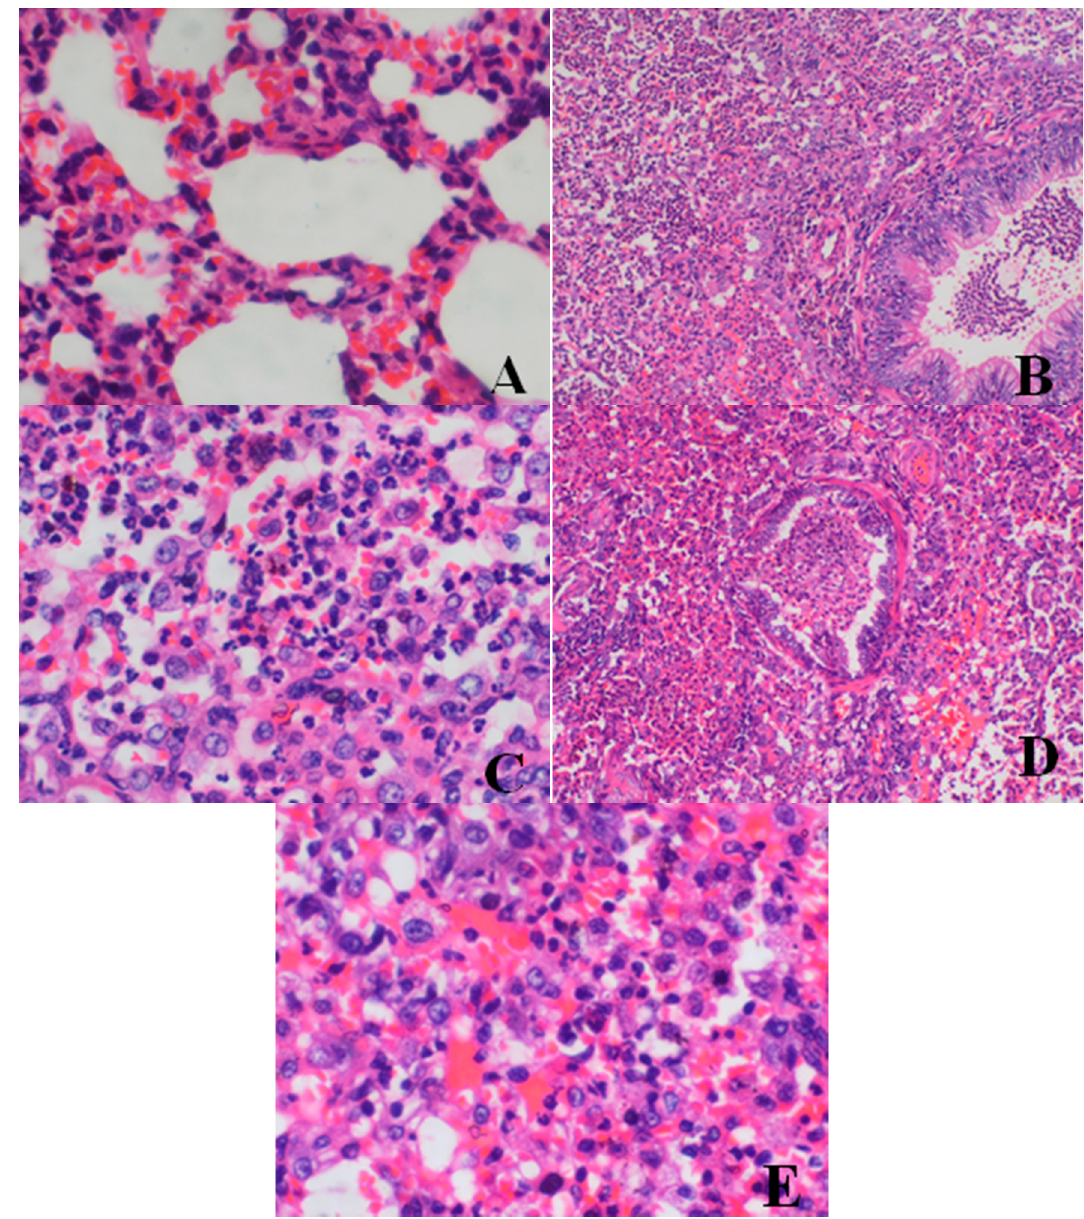
Figure 3. Hematoxylin and eosin-stained histologic sections of dogs’ lungs ( A – E ). ( A ) Histopathological photomicrograph of lung from ♀ 26 belonging to the control group at d28 (original magnification × 400): normal structure; ( B ) lung from ♂ 5 belonging to the 80-mg/kg dose group at d28 (original magnification × 100); ( C ) lung from ♂ 5 belonging to the 80-mg/kg dose group at d28 (original magnification × 400); ( D ) lung from ♂ 23 belonging to the 40-mg/kg dose group at d28 (original magnification × 100); ( E ) lung from ♂ 23 belonging to the 40-mg/kg dose group at d28 (original magnification × 400). Note the alveoli surrounding the nidi disappeared and formed a confluent lesion. Inside the pathological area, some structure of the bronchial wall was destroyed, cilia fell off and large confluent bronchopneumonia pathological changes occurred. Images captured from sections prepared from the necropsy of dogs euthanized at d28.